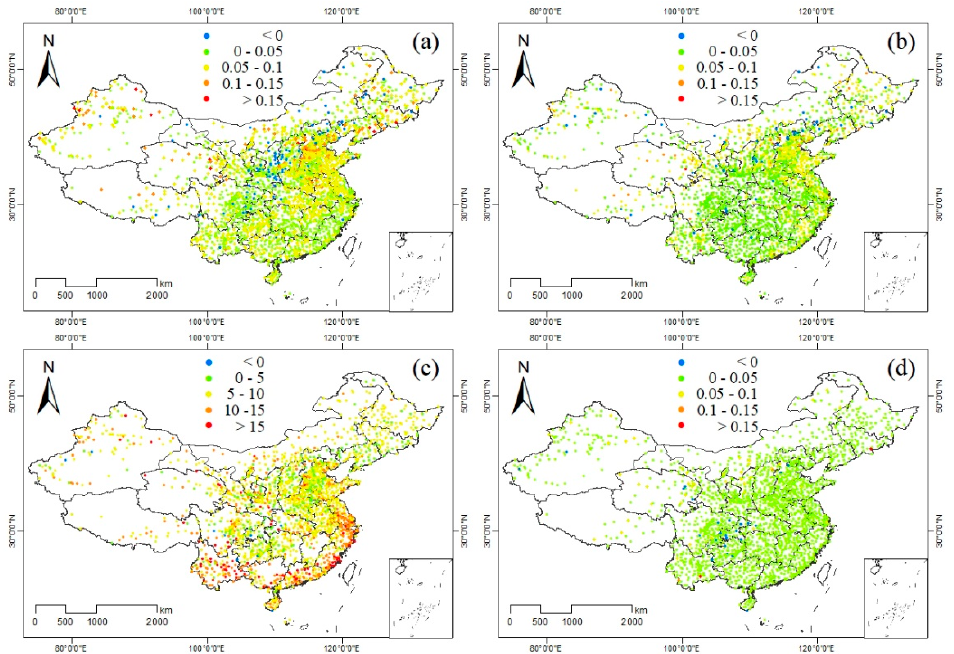
Figure 6. The tendency rate of ( a ) the extreme minimum temperature; ( b ) mean minimum temperature in the coldest month; ( c ) accumulated temperature with daily mean temperature greater than or equal to 10 °C; and ( d ) annual mean temperature for each weather station over the past 60 years (1961–2020) with the p value (significance level) is less than 0.1.